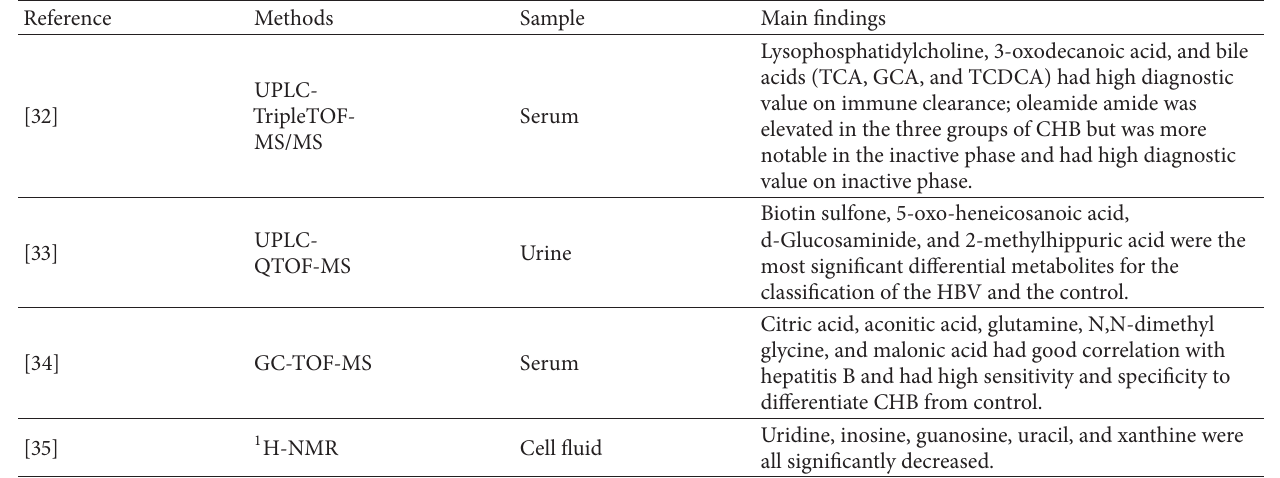
Table 4: The relevant information about researches on CHB.